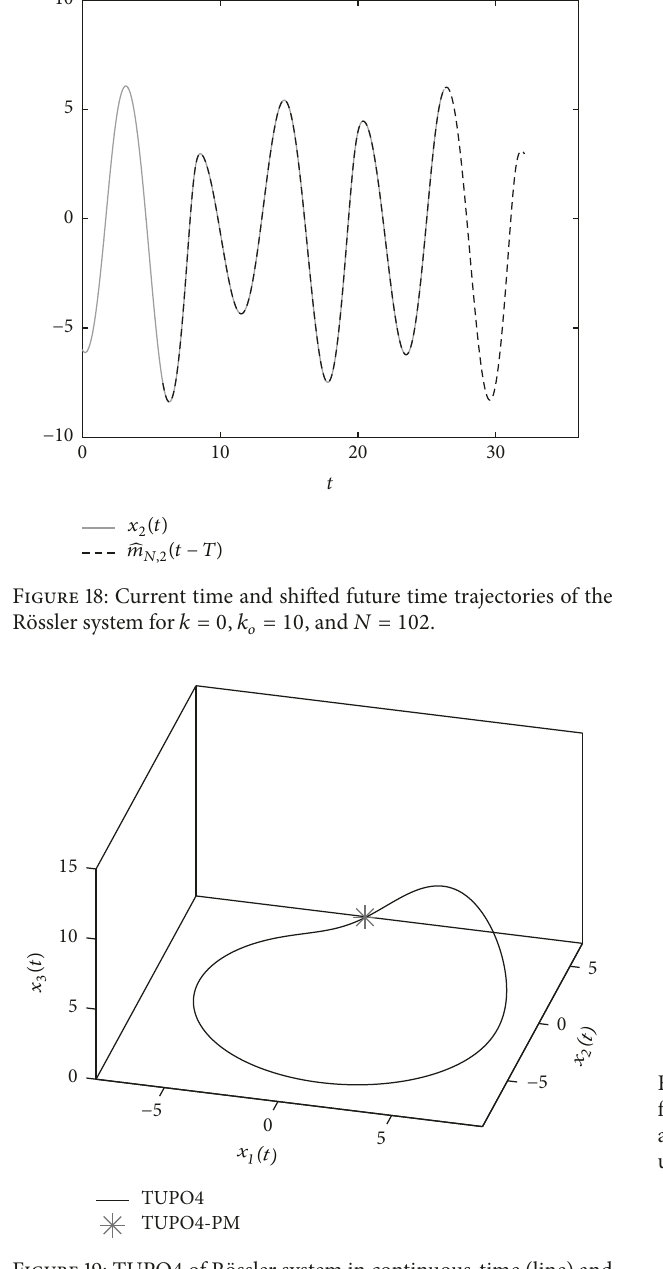
Figure 19: TUPO4 of R¨ossler system in continuous-time (line) and Poincar´e map point ( ∗ ) for 𝛽 1 = 𝛽 2 = 0.2 and 𝛽 3 = 4.5 .